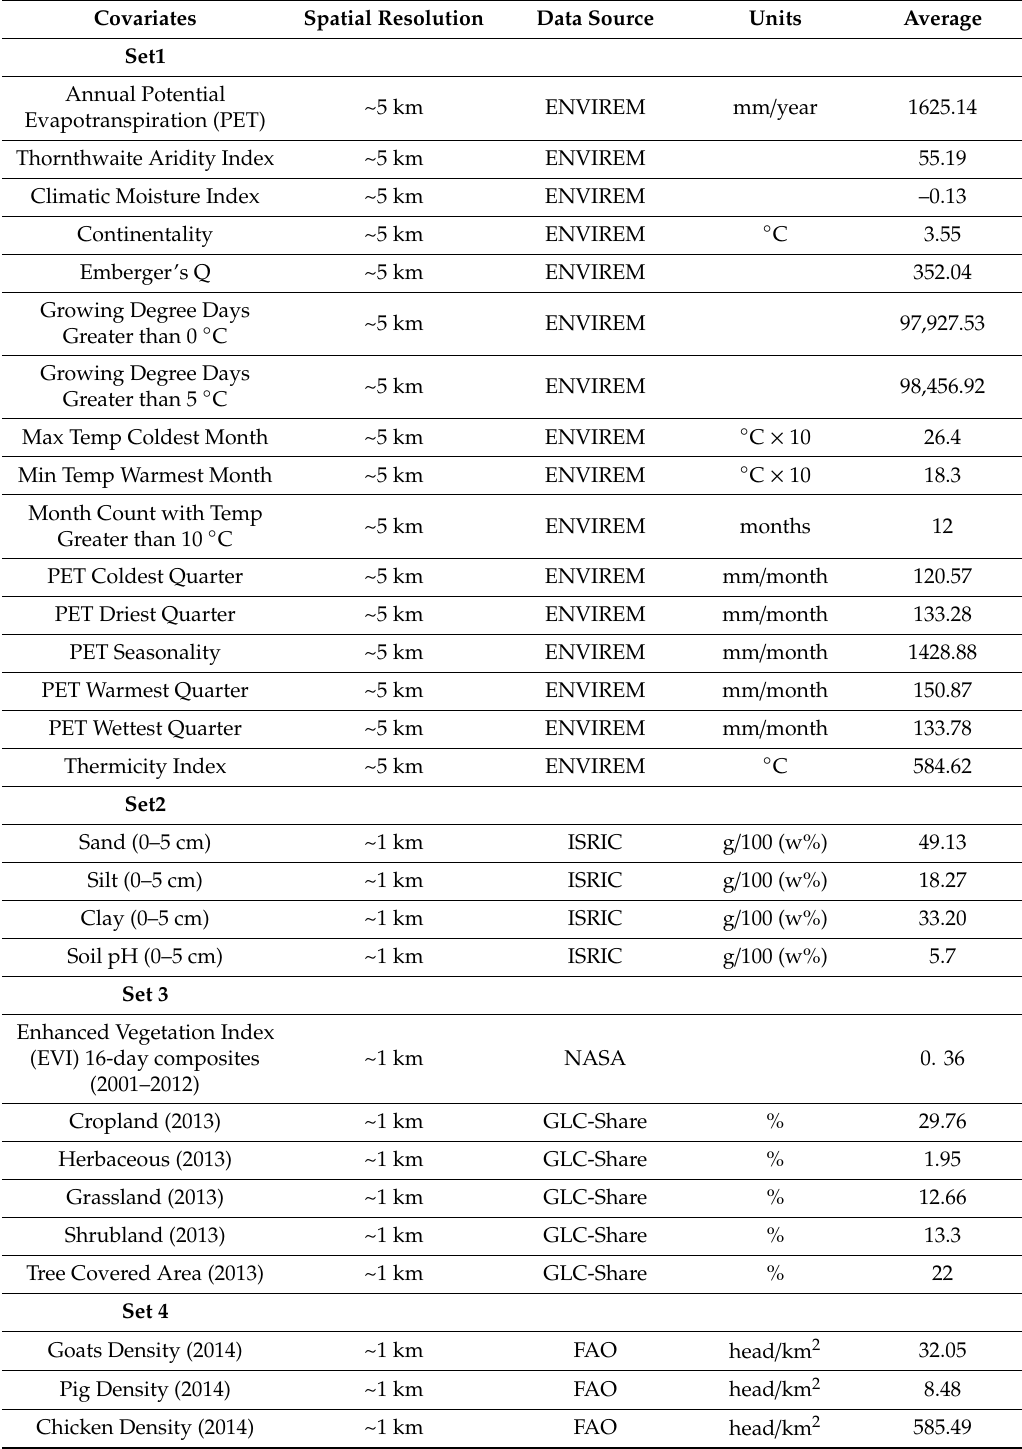
Table 1. Environmental covariates. SSA: sub-Saharan Africa, ENVIREM: ENVIronmental Rasters for Ecological Modeling, ISRIC: International Soil Reference and Information Centre, GLC-Share: Global Landcover Network Share database, FAO: Food and Agricultural Organization of the United Nations, ESRI: Environmental Systems Research Institute, and CIESIN: Center for International Earth Science Information